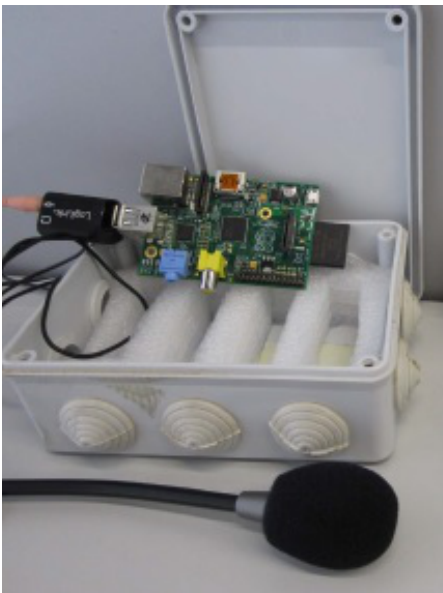
Figure 1. Measurement node setup.